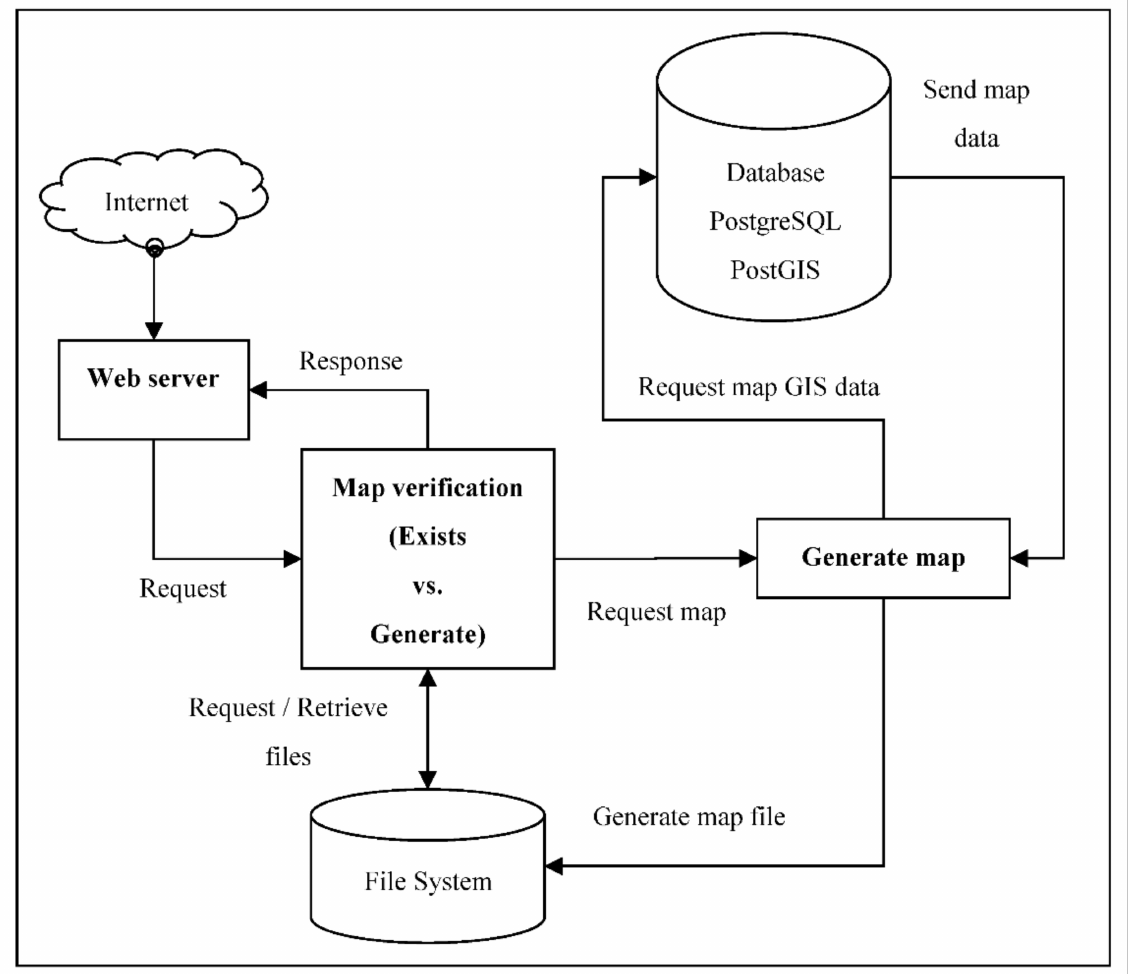
Figure 13. The map server internal structure and functional